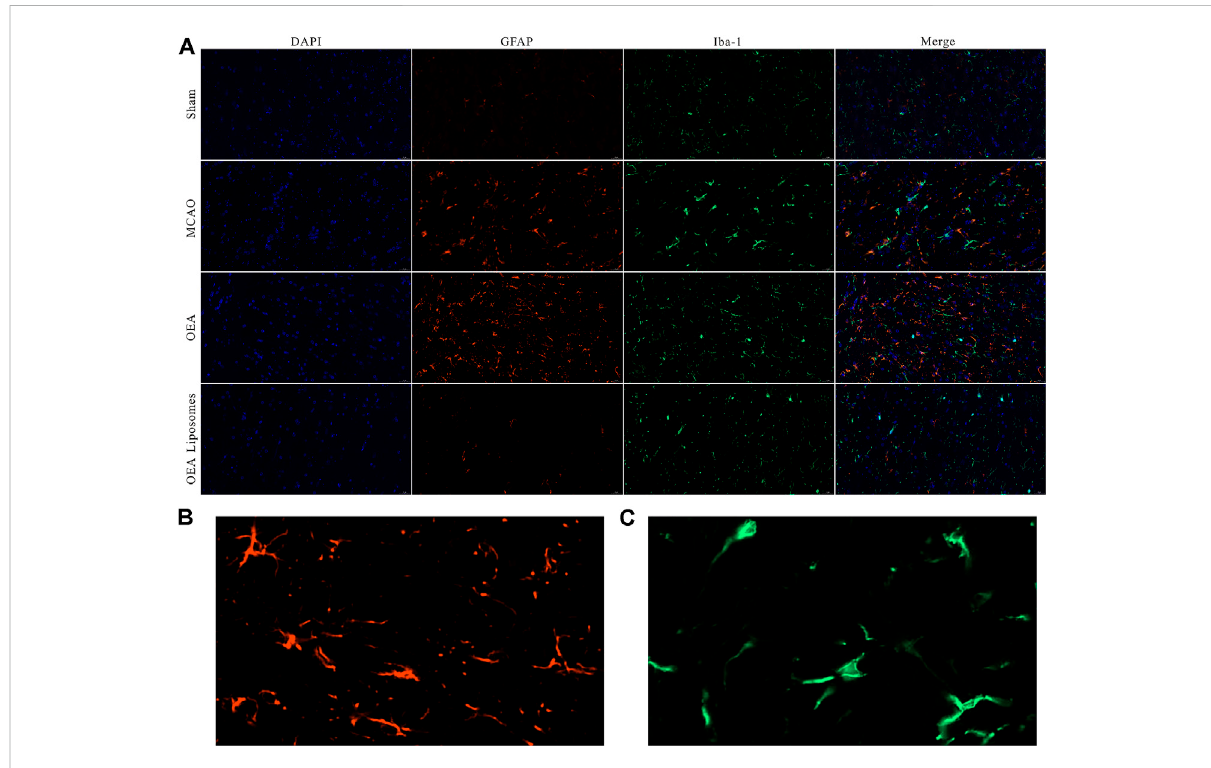
FIGURE 6 (A) TheareaofIBA-1andGFAPpositivestainfromthecortexaroundtheischemicfocus. (B – C) TheenlargedpicturesofIBA-1andGFAPpositive